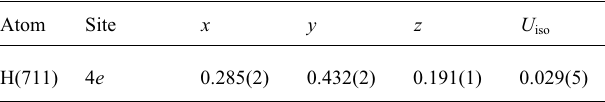
Table 2. Atomic coordinates and displacement parameters (in Å 2 ) .